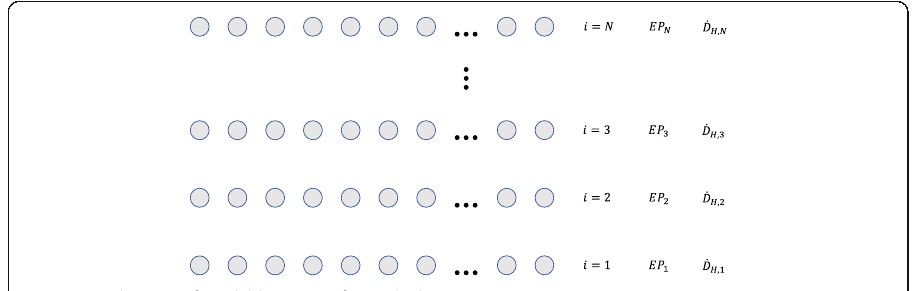
Fig. 4 Visualization of available actions for each discrete time step